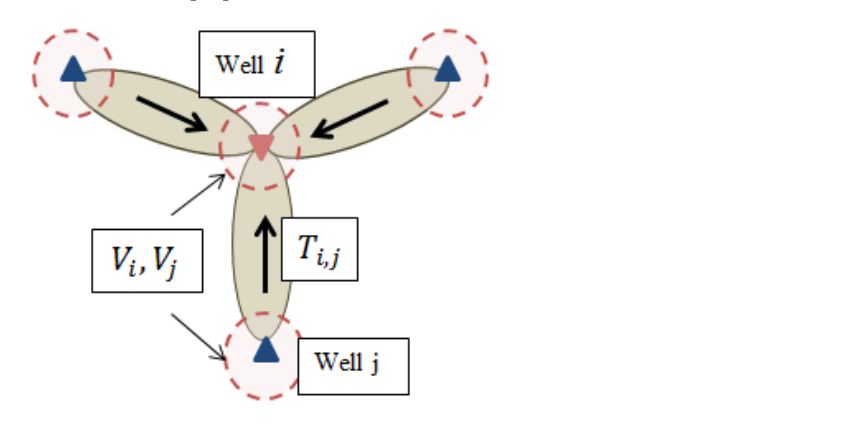
Figure 2. Model with a system of hydrodynamically connected injection and production wells.